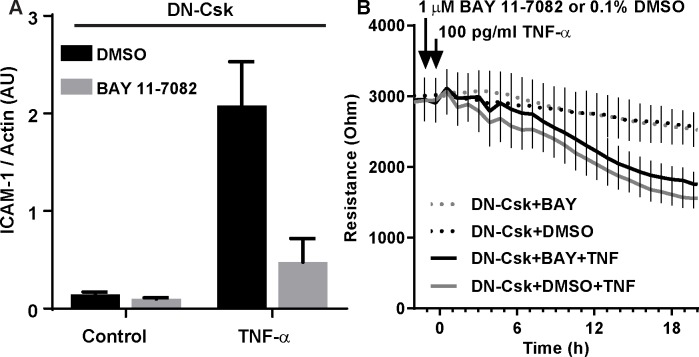
NF-κB is dispensable for the loss of barrier function in LD-TNF/DN-Csk cells.Cells were seeded at confluence and incubated for 72 hours. Then, growth media was replaced by low serum media and cells were infected with adenovirus to express either LacZ (control) or DN-Csk. After another 16 h, cells were pretreated with DMSO (vehicle) or BAY 11–7082 (NF-kB inhibitor) for 30 minutes prior to TNF-α addition. A, Quantification of three independent Western blot experiments demonstrating that BAY 11–7082 is able to prevent ICAM-1 expression in LD-TNF/DN-Csk cells after 8 h of treatment with TNF-α. B, TEER measurements on ECIS electrodes. Notice the lack of effect of BAY 11–7082 treatment on the loss of TEER in LD-TNF/DN-Csk cells. Results are representative of three independent experiments performed in duplicate. Data presented as mean±SEM. Bar graph (mean±SEM) and statistical analysis of TEER for the 20 h time point corresponding to B is shown in S6F Fig.